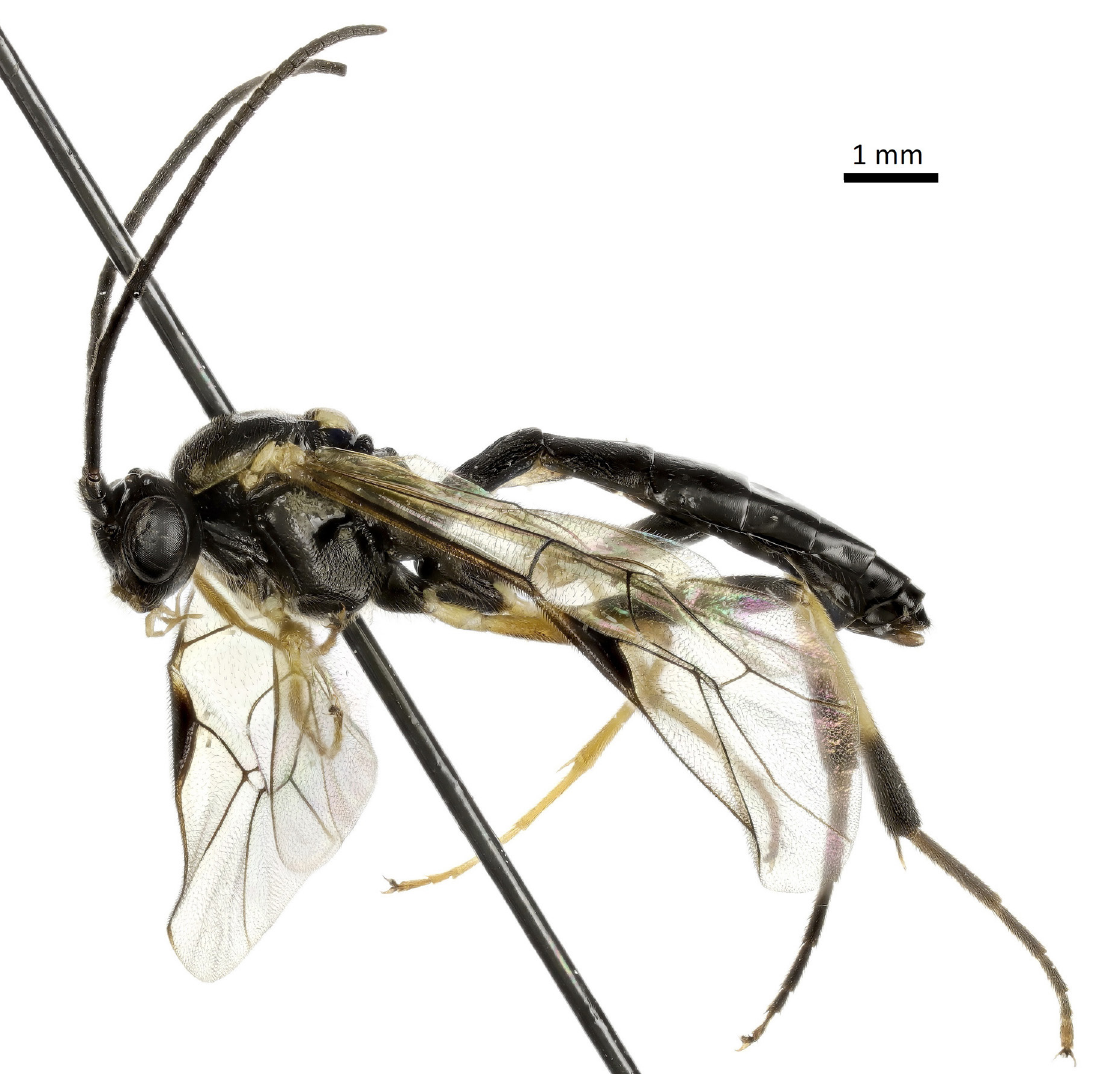
Fig. 3. Homotropus klopfsteinae sp. nov., holotype, ♀ (NHRS-HEVA000011629). Habitus, lateral